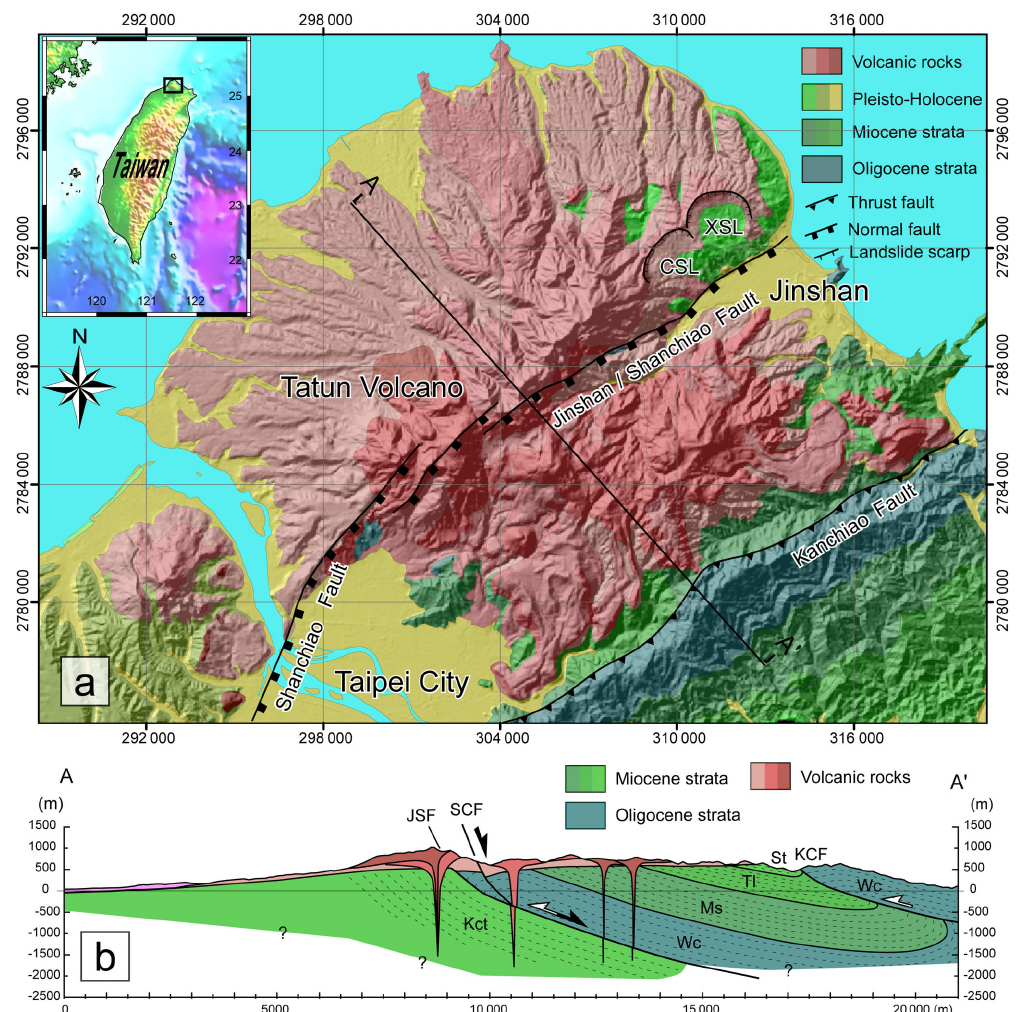
Figure 1. Geological and geomorphological map of the study area. (a) Geodynamic map of the island of Taiwan and its northern region, illustrating the regional tectonic structures and the geology near the sliding area. (b) Geological cross section of the study area, considered to be a region of imbricated, west-vergent, NE–SW-trending folds and thrusts in the Taiwan mountain belt. The compressive synorogenic and postorogenic activities separate the successive sedimentary rocks by the Kanchiao Fault (KCF), Jinshan Fault (JSF), and Shanchiao Fault (SCF, also known as the Jinshan Fault through normal faulting). Two landslide sites, the Xishi landslide (XSL) and Chinshui landslide (CSL), are denoted in the figure. The corresponding strata in the cross section, from bottom to top, are the late Oligocene Wuchihshan Formation (Wc), Miocene Mushan Formation (Ms), Miocene Taliao Formation (Tl), Miocene Shihti Formation (St), and Mio-Pliocene Kueichulin Formation